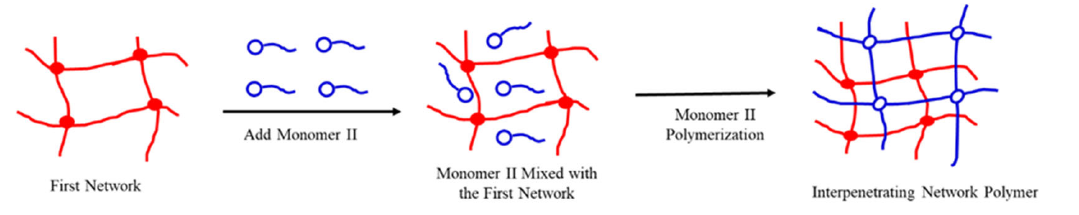
Figure 10. The diagram of interpenetrating polymer networks prepared by stepwise manner.